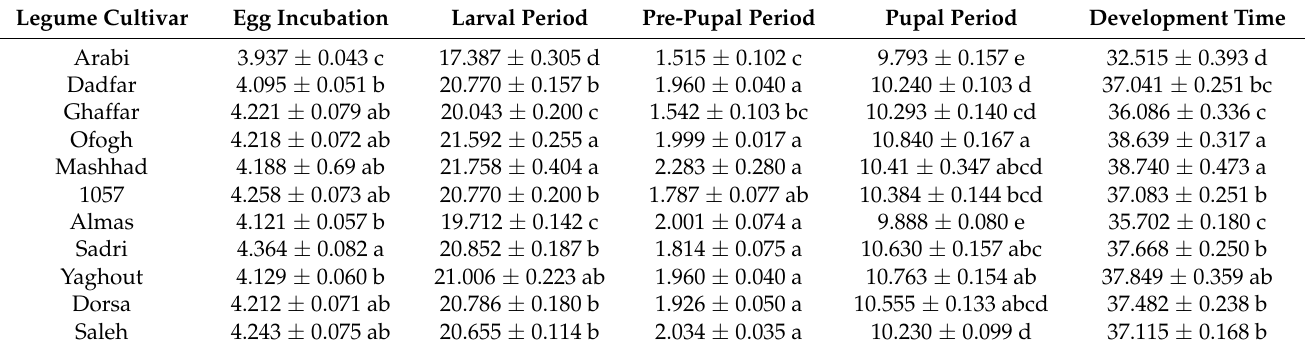
Table 1. The duration (day) and survival of immature stages (mean ± SE) of Spodoptera littoralis reared on various legume